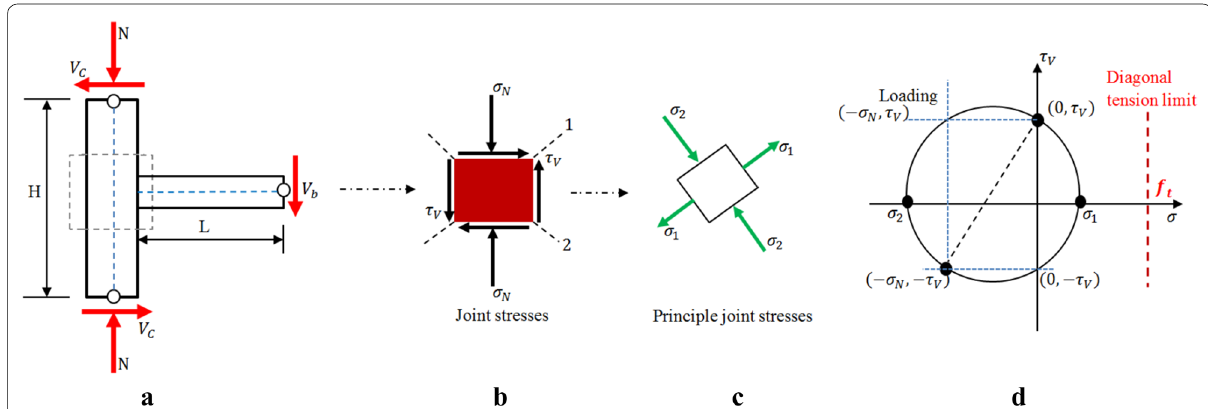
Fig. 26 a External loads; b connection stresses; c principle stresses; d Mohr